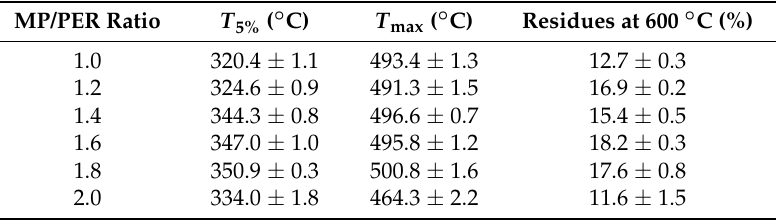
Table 1. TGA data of MP/PER/PP masterbatches with different molar ratio of MP and PER.